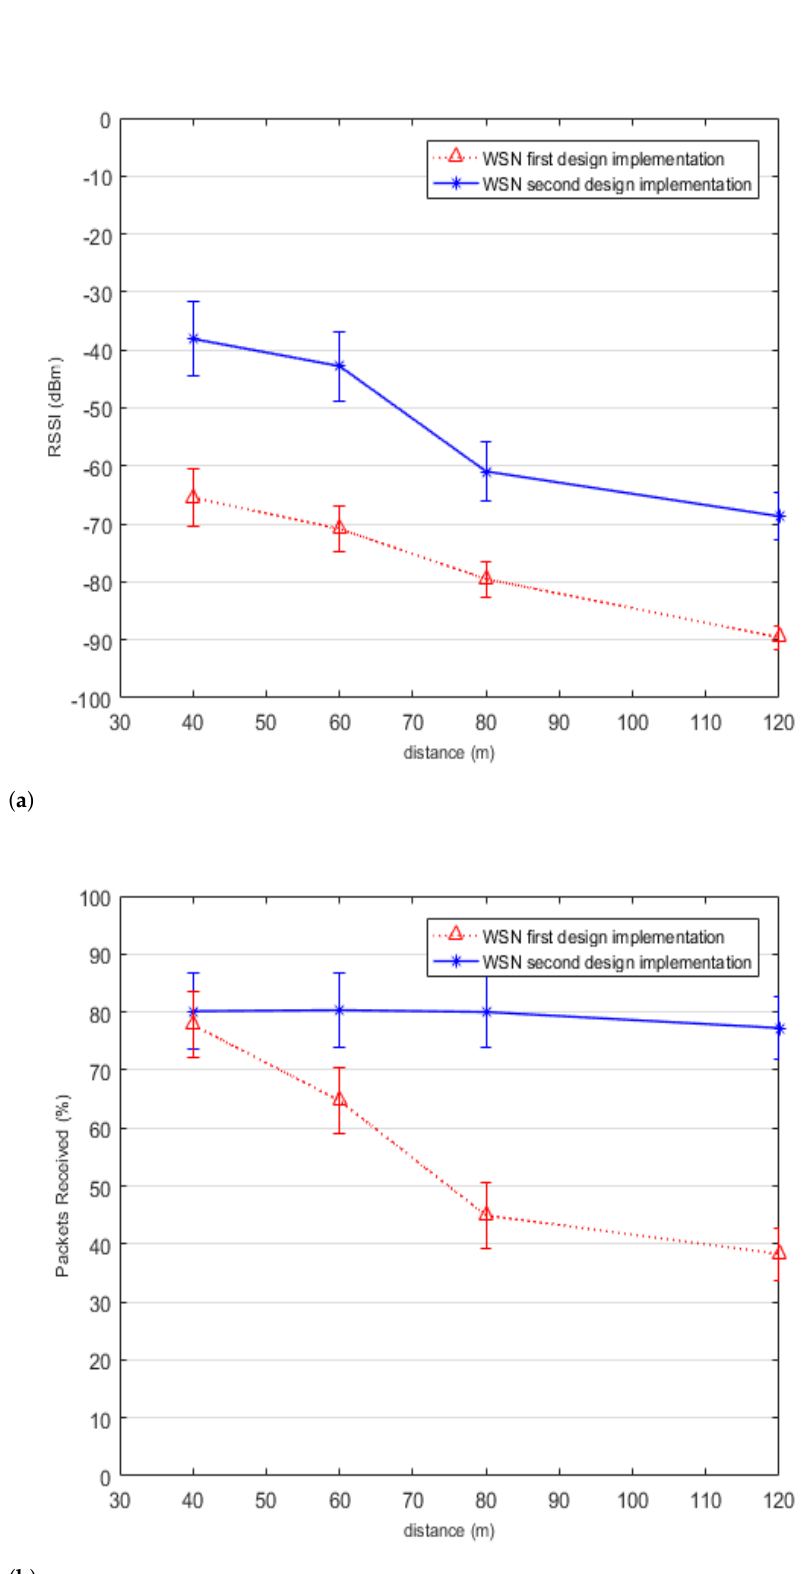
Figure 14. Performance evaluation and comparison between the first and second WSNs implementa- tions depicting ( a ) RSSI, ( b ) Packets received